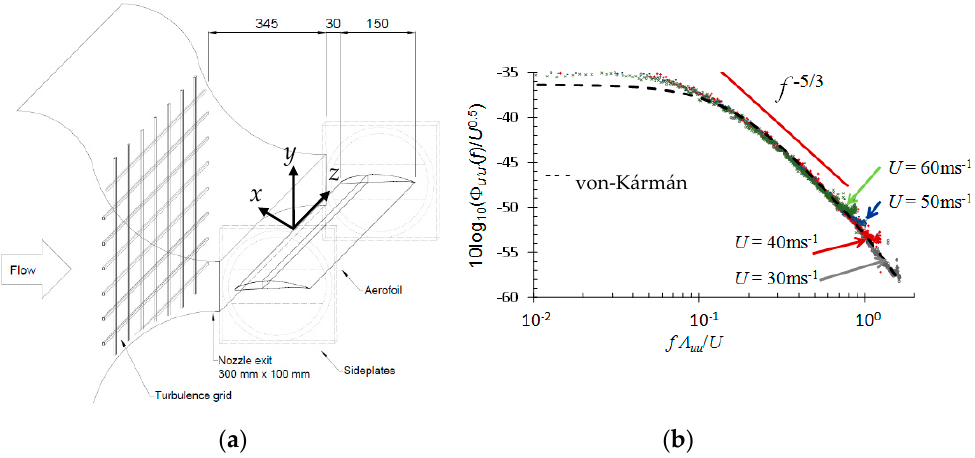
Figure 2. ( a ) Placement of the turbulence bi-planar grid inside the nozzle of the aeroacoustics wind tunnel; ( b ) comparison of the normalized turbulent energy spectra between the experimental results and the von-K á rm á n model for the longitudinal velocity fluctuations. The streamwise location of the measurement corresponds to the leading edge of the aerofoil (30 mm from the nozzle exit), but without the presence of the aerofoil.